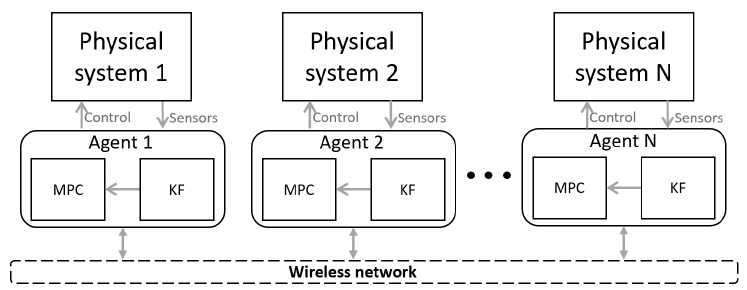
Figure 1. Cyber representation of a multi-agent system introduced in